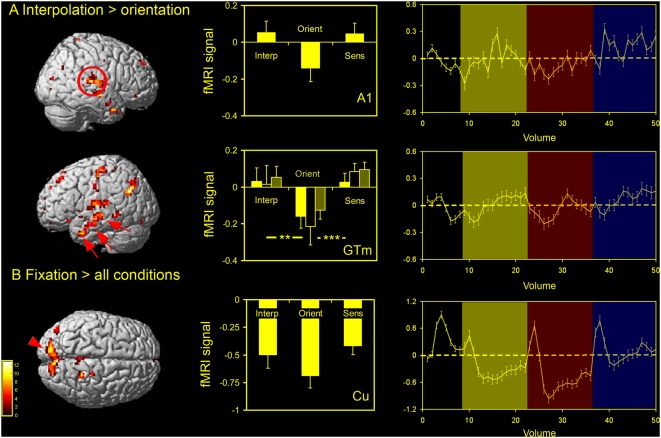
Deactivations relative to fixation.Clusters of relative activation / deactivation from the random effects group analysis [see Table 2 for foci; P<0.001 (uncorrected) threshold] are shown along with plots of % BOLD signal change relative to fixation (centre column; group data) and the corresponding averaged time-series (right column) from the following contrasts: (A) interpolation versus orientation and (B) fixation versus all conditions. Several clusters of relative activity in the interpolation versus orientation contrast were found to be due to de-activations in the orientation condition (% BOLD signal change relative to fixation). Significant clusters include the primary auditory cortex bilaterally (A1: red ring) and the middle temporal gyrus bilaterally (GTm: red arrows). For the GTm, clusters of activity were divided into three groups bilaterally, generating three sub-regions moving from posterior, through central and on towards more anterior regions (yellow, black and light yellow / grey plots respectively). The only region showing deactivations (relative to fixation) in all conditions was a large midline cluster pertaining to the pre-cuneus / cuneus (Cu: red arrow-head), a well-documented component of the ‘default network’. (See text for details). Conditions: [Interp, interpolation; Orient, orientation; Sens, sensorimotor control]. ** P<0.01; *** P<0.001 (one-way ANOVA with Tukey's post hoc analysis).